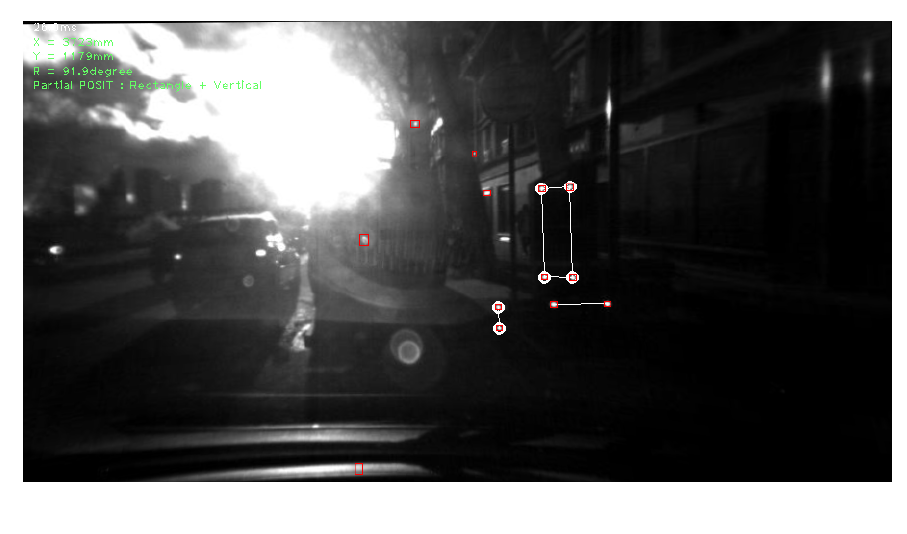
Figure 7. Typical view from the system, on the side of a busy